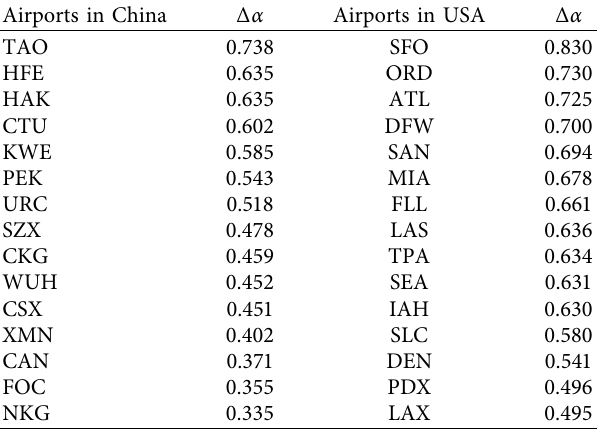
Table 4: Ranges of singularity spectra of the airports. Airports in